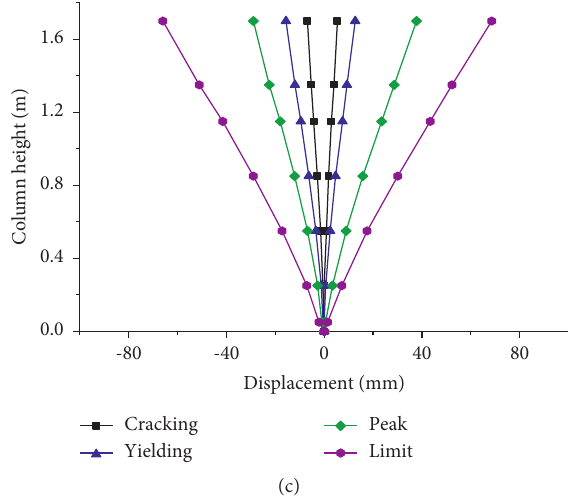
Figure 18: Distribution of horizontal displacement. (a) XZ1. (b) YZ1. (c) YZ2.